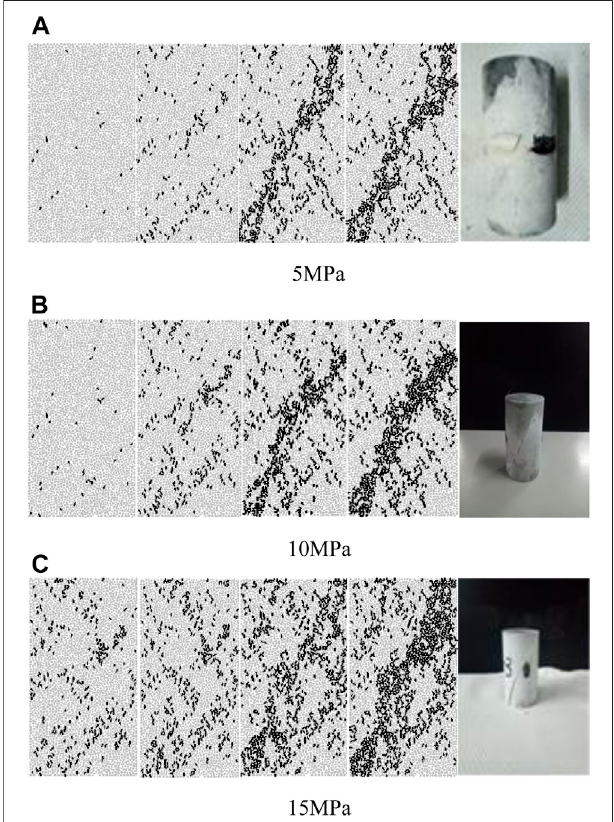
FIGURE 5 | Crack distribution evolution and failure patterns of marble samples under various con fi ning